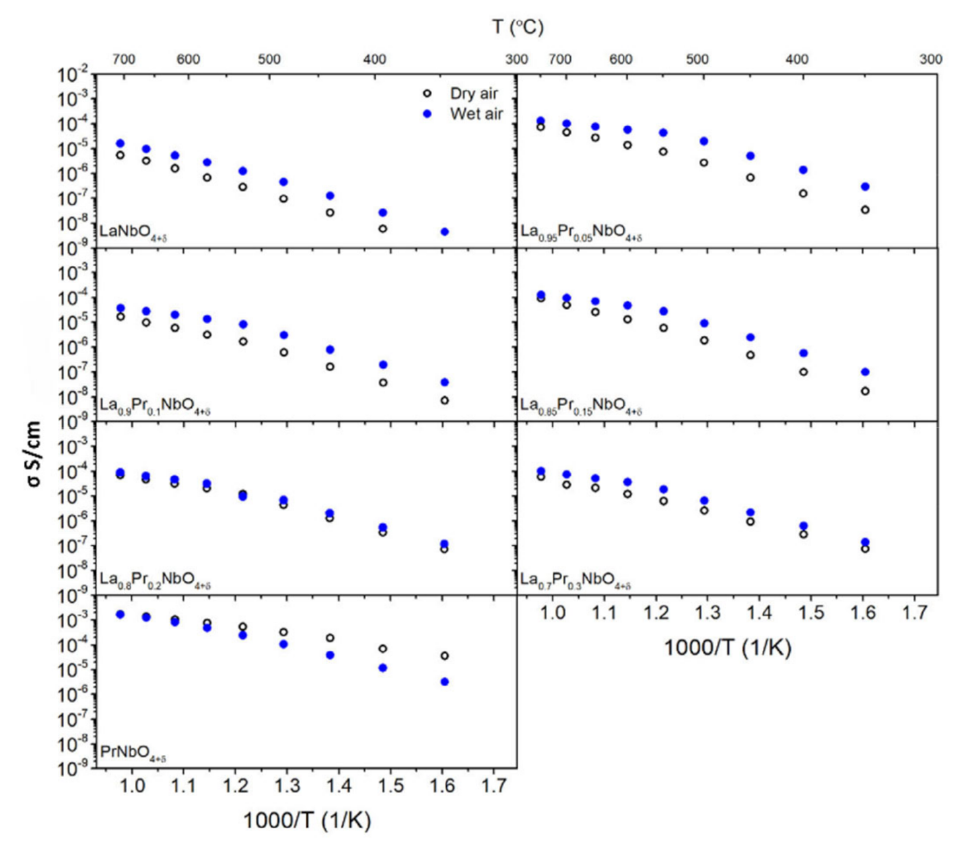
Figure 8. Total conductivity of La 1 − x Pr x NbO 4+ δ as a function of temperature in dry (pH 2 O = 6.0 × 10 − 5 atm) and wet (pH 2 O = 2.4 × 10 − 2 atm)